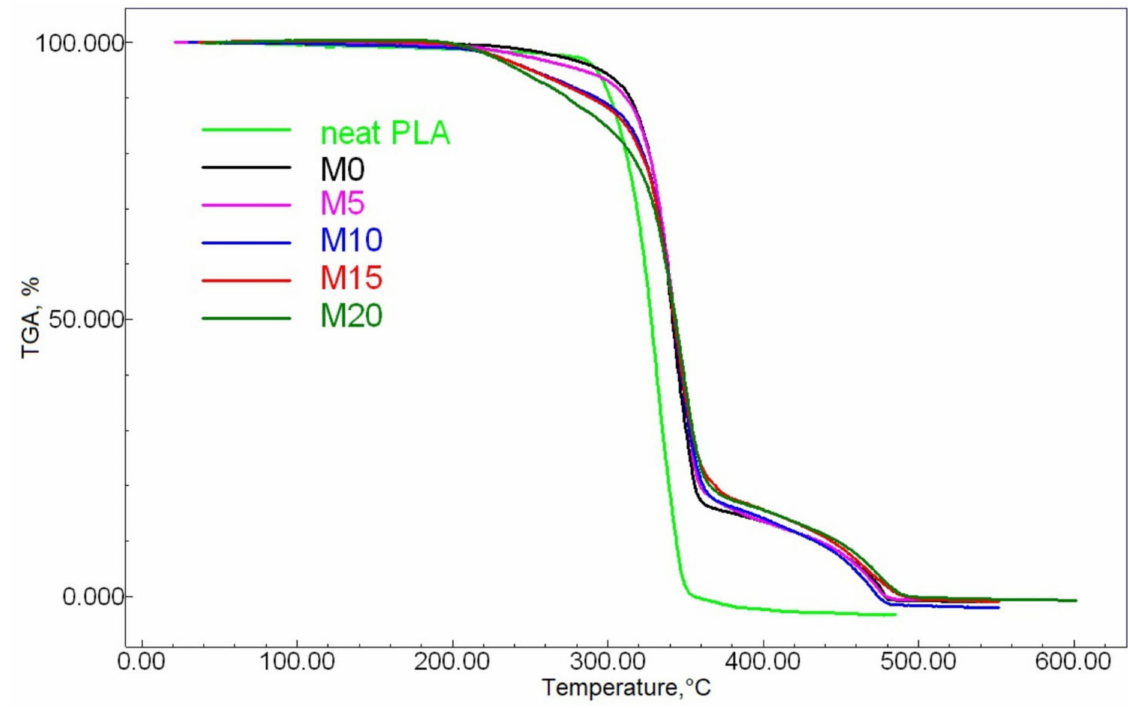
Figure 2. The samples’ TGA